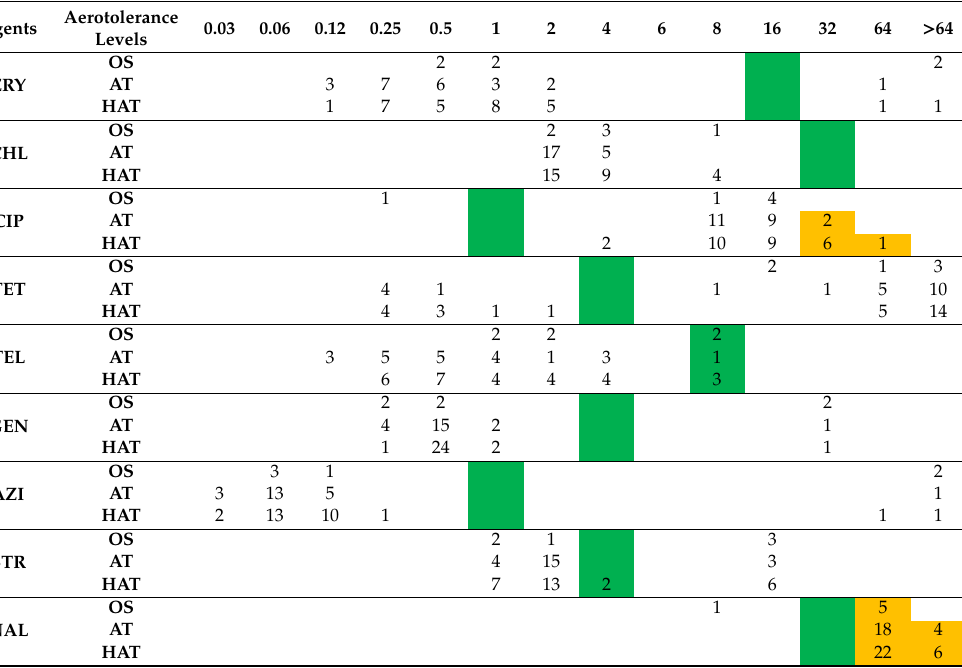
Table 2. Distribution of minimum inhibitory concentration (MIC) values ( µ g / mL) for C. coli isolates according to aerotolerance levels.